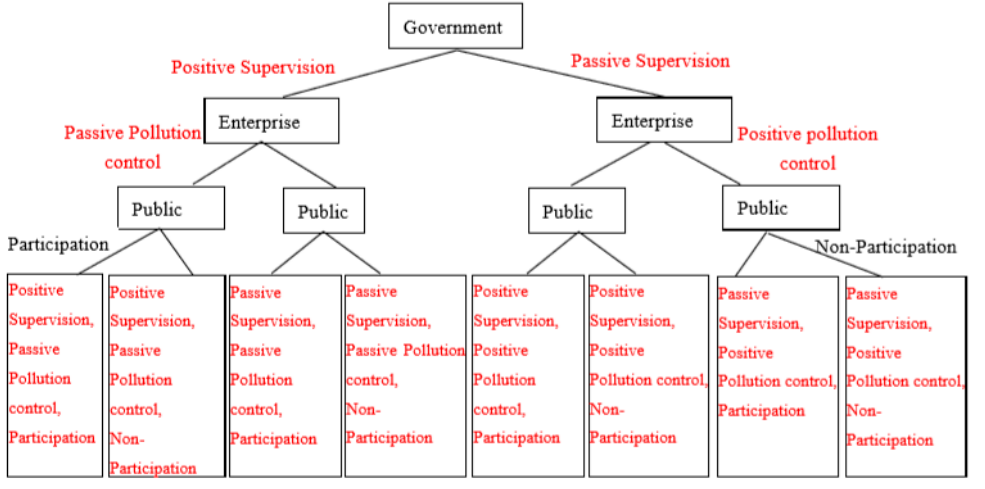
Figure 1. Tripartite game strategies.